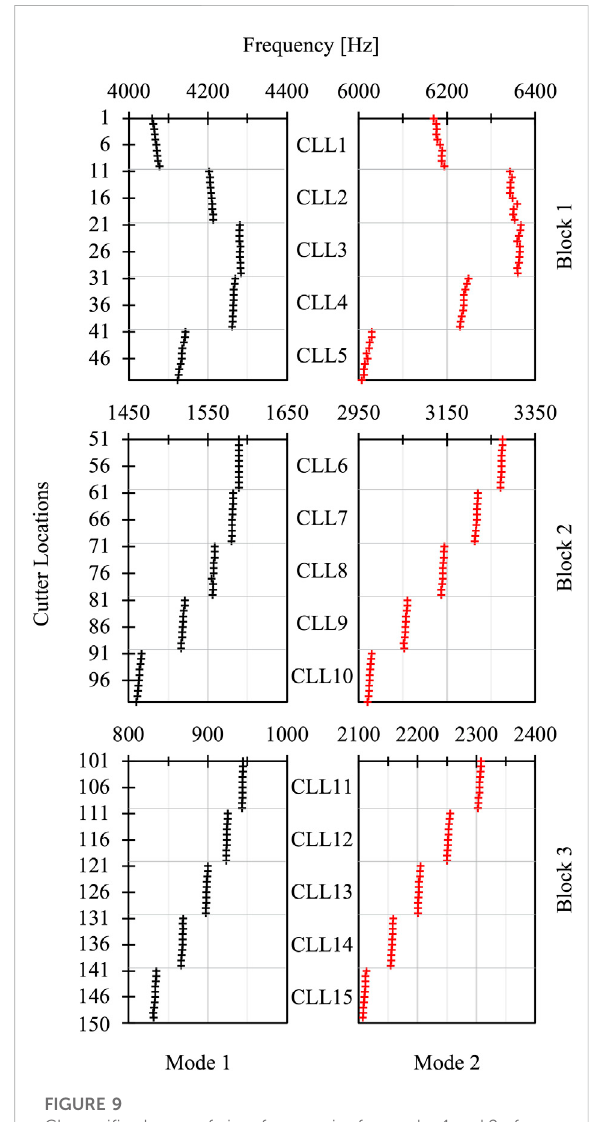
FIGURE 9 CL speci fi c change of eigenfrequencies for modes 1 and 2 of block 1 to